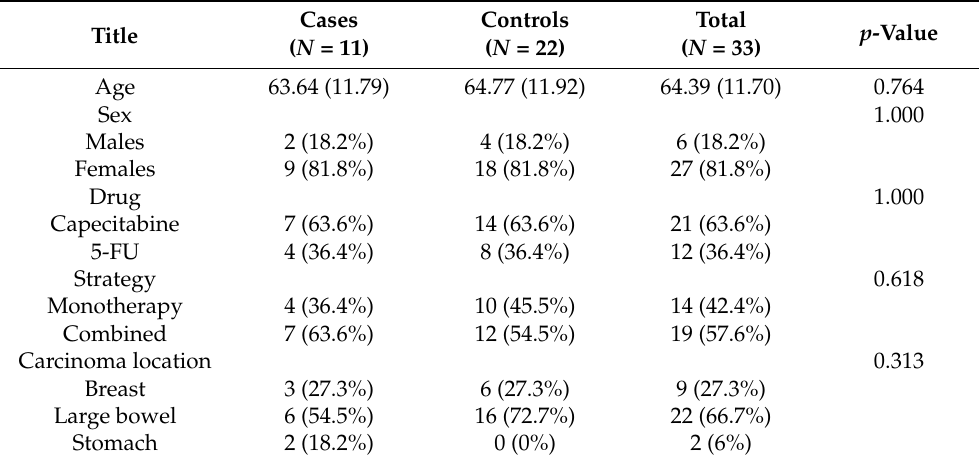
Table 1. Baseline characteristics of cases and